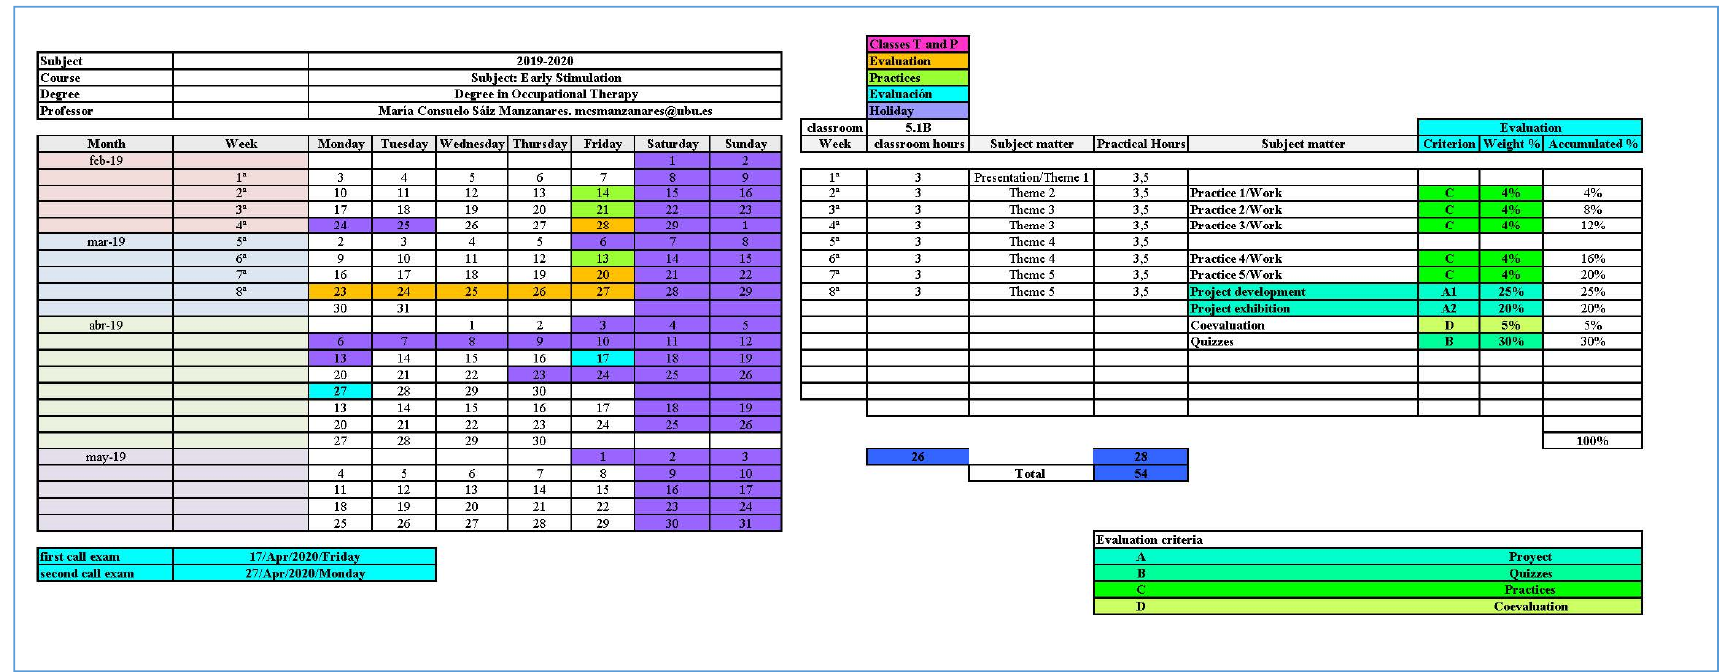
Figure 3. Process and procedure schedule.